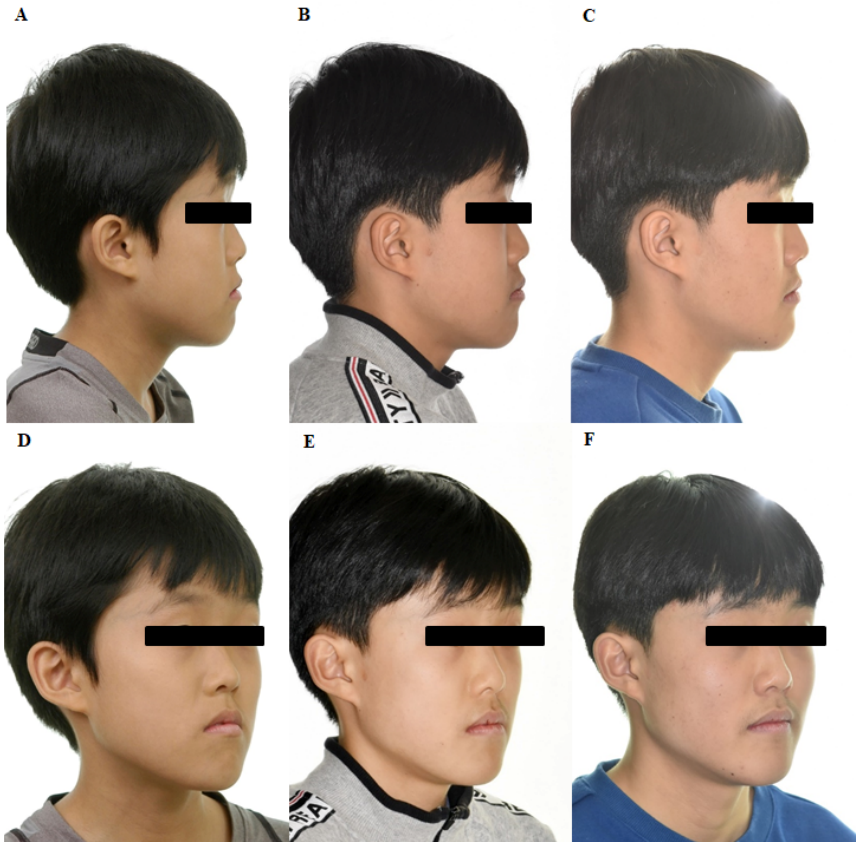
Figure 1. Facial photographs showing lateral and 45 degree profiles ( A , D ) at initial, ( B , E ) 12 months after customized bone-anchored maxillary protraction (BAMP) therapy, and ( C , F ) 24 months after customized BAMP therapy.